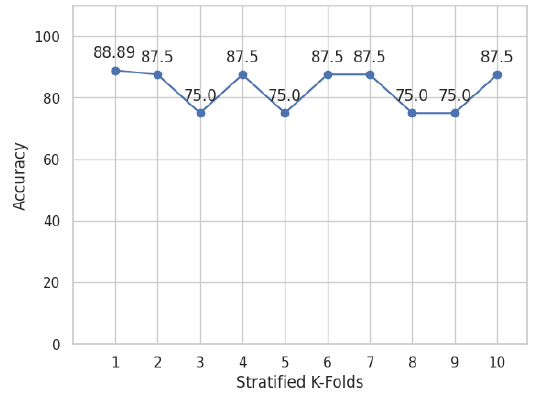
Figure 5. The classification accuracies of the NB model using the stratified ten-fold cross-valida- tion-2.